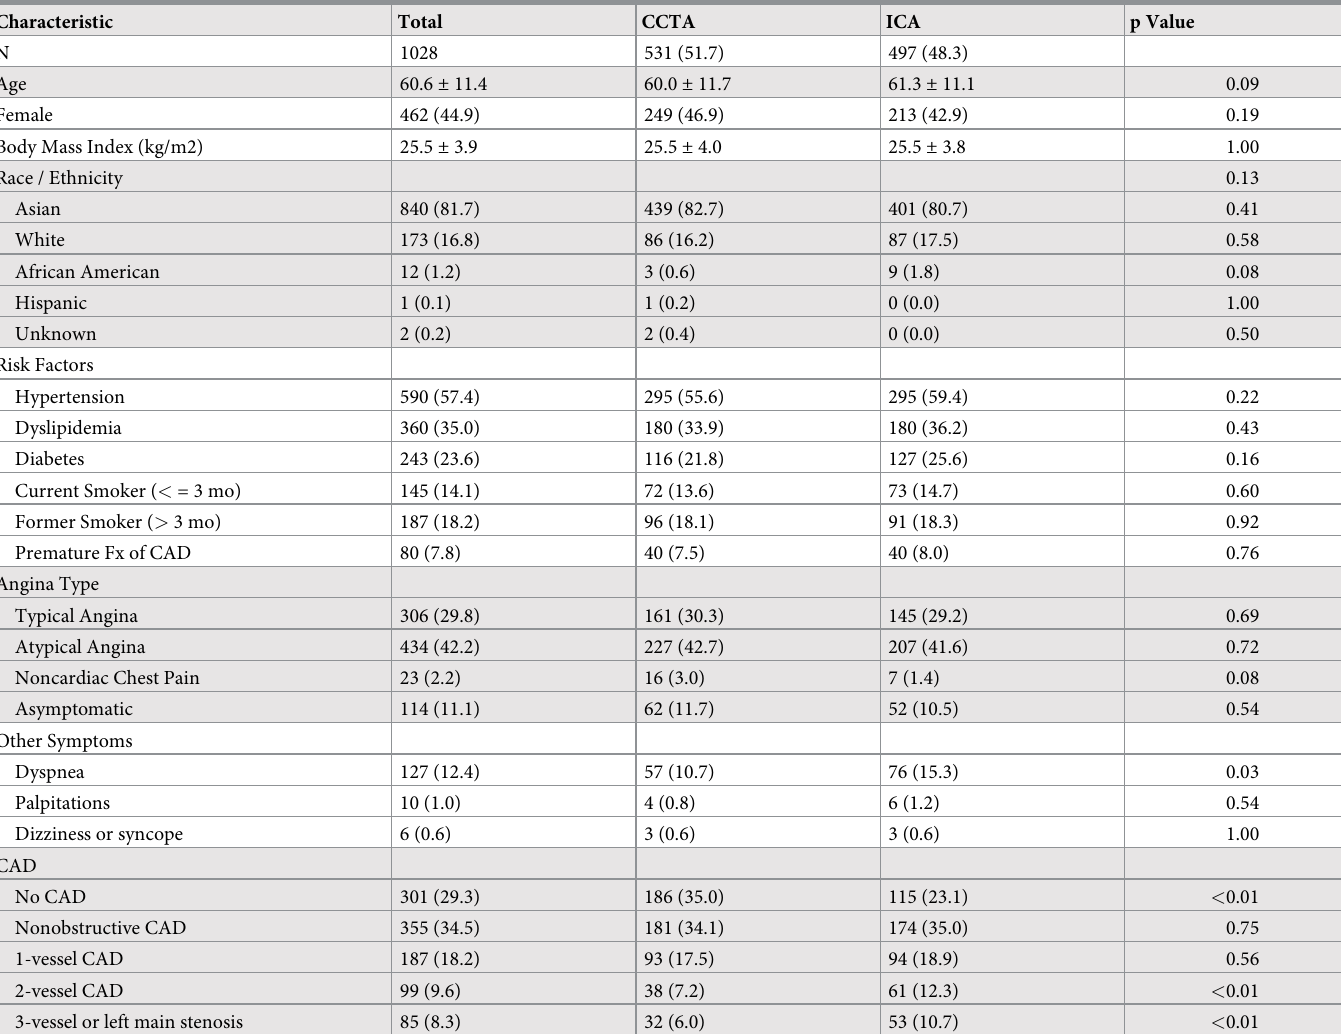
Table 1. Baseline